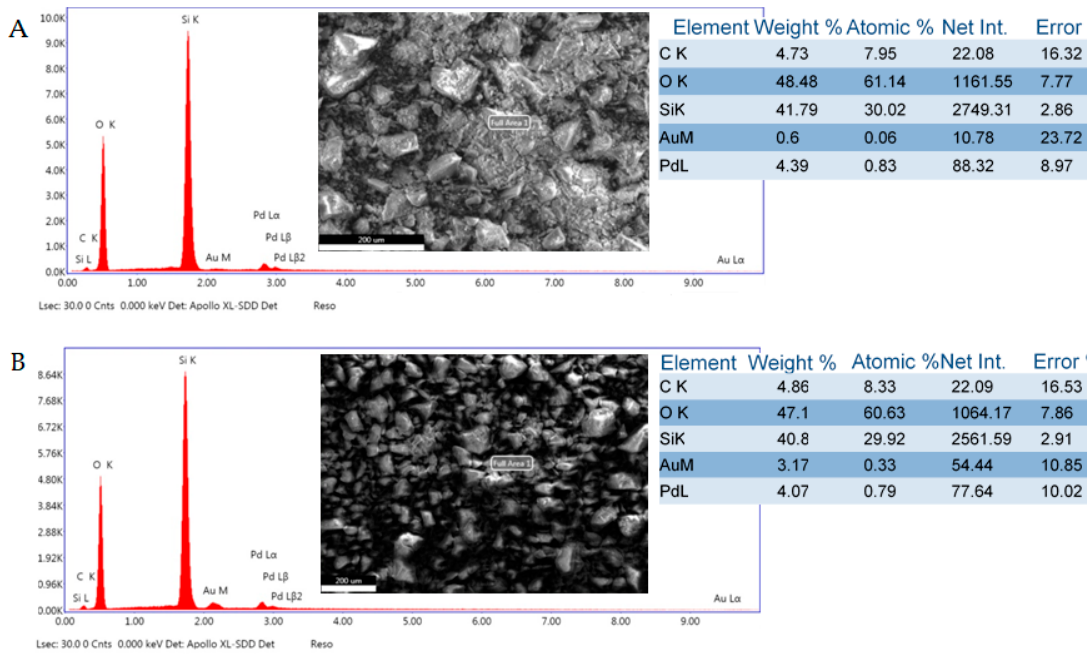
Figure 4. SEM-EDS surface composition analysis: ( A )—5%Pd-1%Au / SiO 2 catalyst; ( B )—5%Pd-5%Au / SiO 2 catalyst.